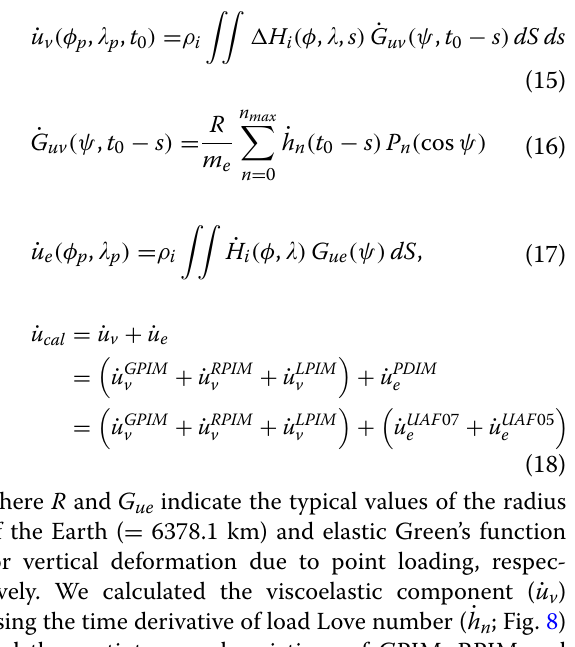
where R and G ue indicate the typical values of the radius of the Earth ( 6378.1 km) and elastic Green’s function = for vertical deformation due to point loading, respec- tively. We calculated the viscoelastic component ( using the time derivative of load Love number ( and the spatiotemporal variations of GPIM, RPIM and